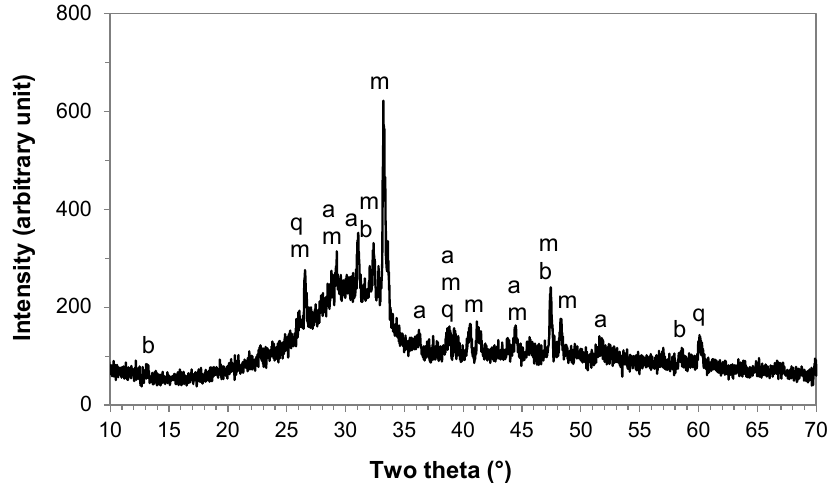
Figure A2. Particle size distribution of MK.